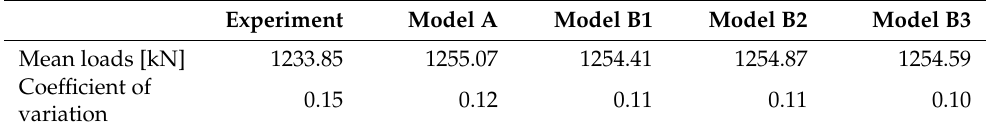
Table 6. Mean and coefficient of variation (CoV) values for up-wave mooring line